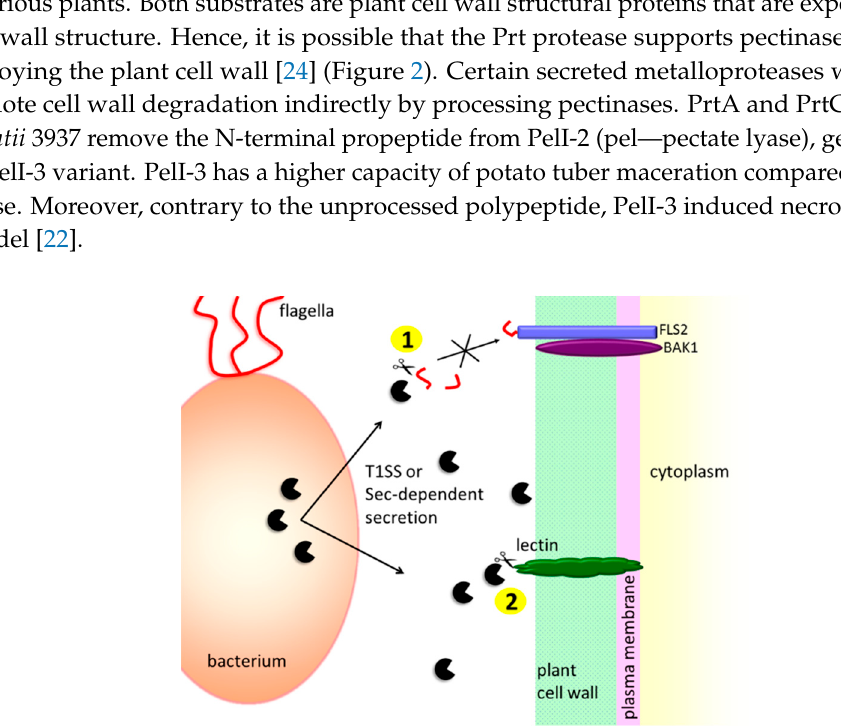
Figure 2. The extracellular bacterial metalloproteases prevent the recognition of the pathogen by the plant, and contribute to plant cell wall degradation. (1) Protease AprA degrades the monomers of flagellin, and thus disables the signaling from the FLS2 receptor [116]. (2) Secreted Prt proteases are believed to participate in the degradation of the plant cell wall. For example, Prt1 from P. carotovorum in vitro cuts the plant cell wall structural proteins, potato lectin, and extensins [24].